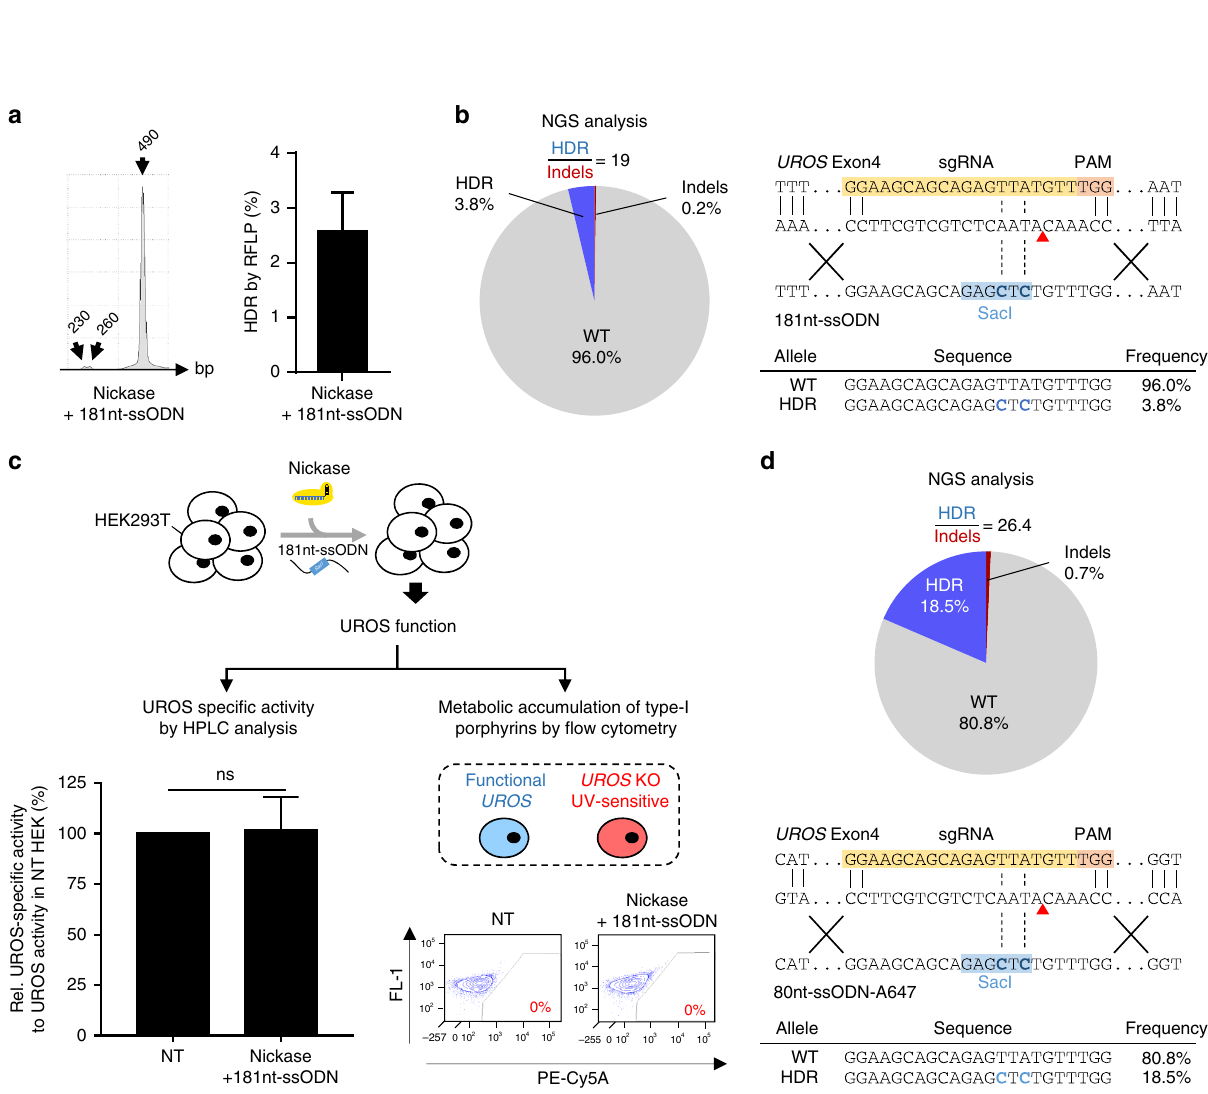
Fig. 3 Unique DSB impairs chromosomal integrity. a , b DNA-FISH assay using ( a ) UROS -framing probes (respectively − 4.6 Mb upstream and + 4.4 Mb downstream from UROS locus) or ( b ) Chr10-speci fi c sub-telomeric probes for NT HEK293T cells or cells transfected with nuclease only, nuclease + ssODN or nickase + ssODN. For the two couples of probes, green (G) and orange (O) fl uorescent probes are respectively upstream and downstream of the UROS gene. In this way, Chr10q terminal truncation is denoted by loss of orange signals. (Left) quanti fi cation of cells with 3 O/3 G, 2 O/3 G or 1 O/3 G signals. (Right) Illustrative DNA-FISH results for HEK293T. Statistical signi fi cance is inferred using two-sided chi-square test (versus NT cells). ns, not signi fi cant; * p < 0.05 ** p < 0.01. c Array-CGH on truncated clones. First, HEK293T were transfected with nuclease and analyzed by FISH using UROS -framing probes. Transfected cells were subcloned and 3 out of 10 clones were identi fi ed as 2 O/3 G. Chromosome 10 integrity of clones #8 and #10 was evaluated by array-CGH. Deletion in #10: arr[GRCh37] 10q26.2q26.3(127516127_135404523)x2. Duplication and deletion in clone #8. arr [GRCh37] 10q24.1q26.2(95667790_127496056)x3~4,10q26.2q26.3(127516127_135404523)x2. d DNA-FISH assay using UROS -framing probes for primary wild-type fresh hFF (human Foreskin Fibroblasts) (hFF), immortalized with hTERT (hFF hTERT ) or TP53 − / − immortalized fi broblasts (hFF hTERT TP53 − / − ), NT or transfected with nuclease. Quanti fi cation of 2 O/2 G and 1 O/2 G signals percentages. For ( a , b , c ), source data are provided